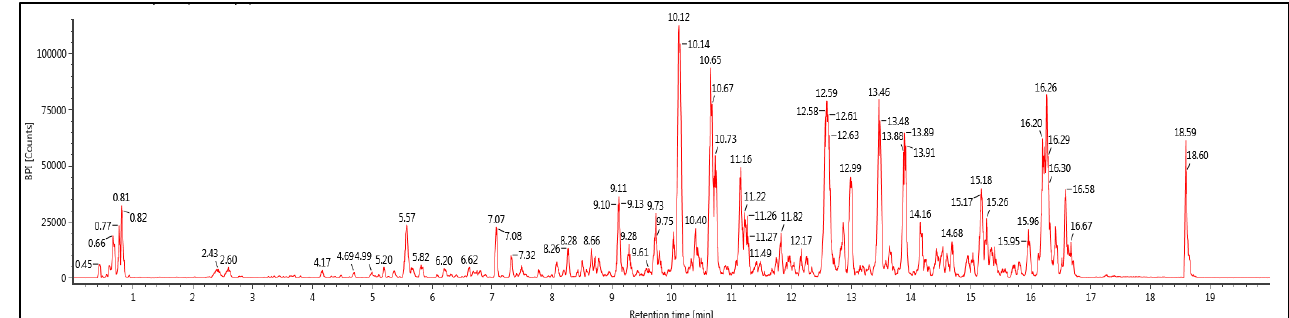
Figure 2. UHPLC-QTOF-MS base peak intensity (BPI) metabolic profile of ethanol extract of A. paniculata .